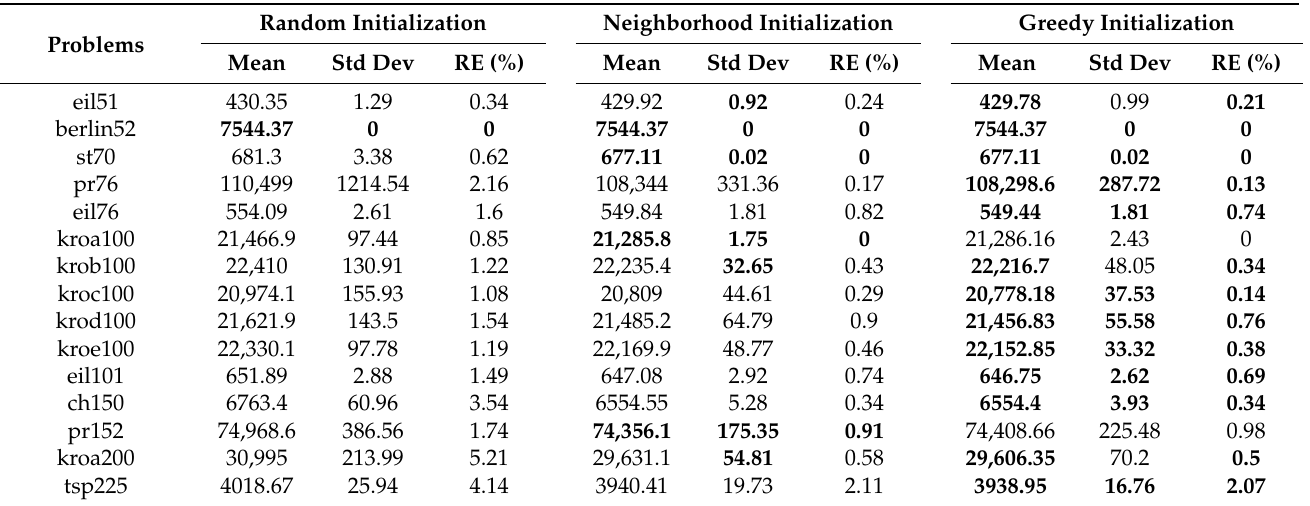
Table 2. Comparisons with random initialization, neighborhood initialization, and greedy initializa- tion on fifteen benchmark